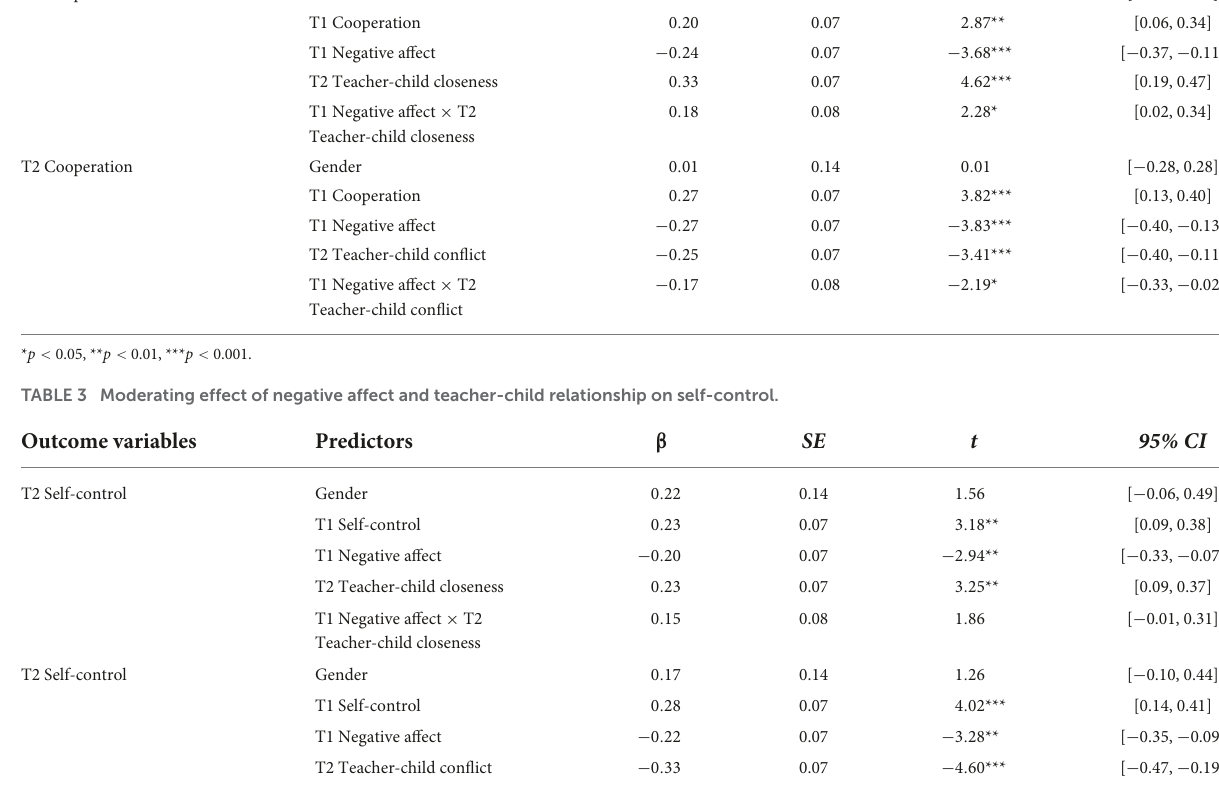
T2 Self-control